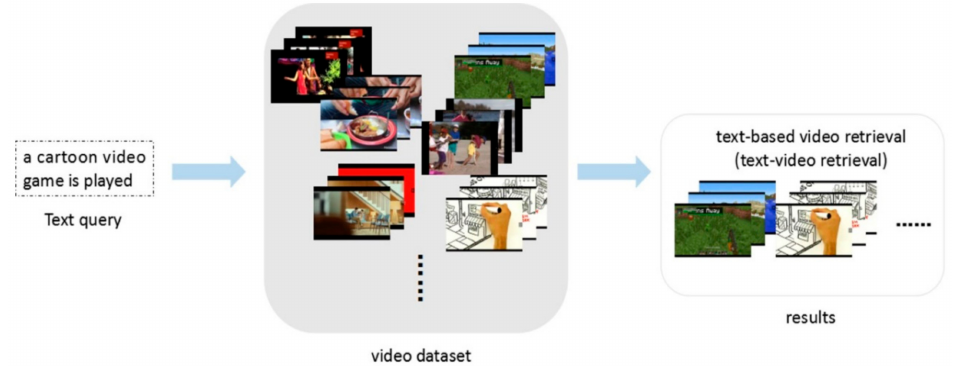
Figure 1. Illustration of text-based video retrieval task. On the left, the text is taken as an input query to retrieve the corresponding video in order.